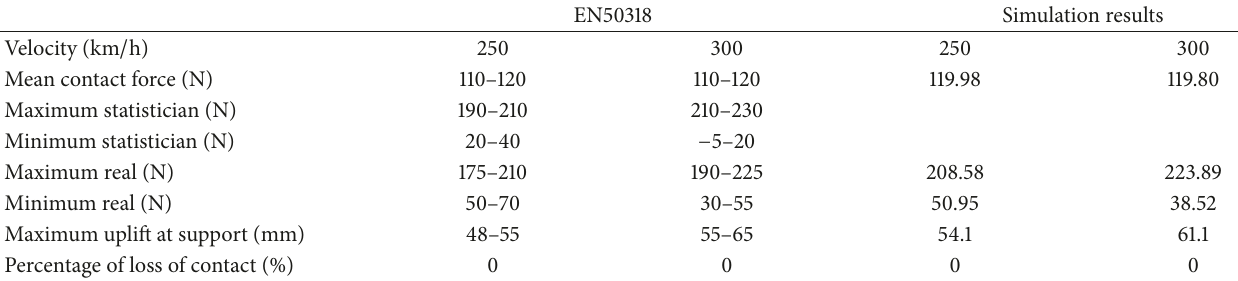
Table 3: Comparison of standard EN50318 and the simulation results.